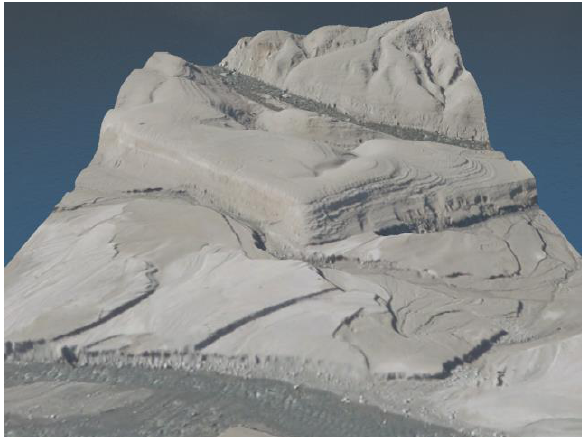
Figure 3. Example of an image draped onto the DIM surface.